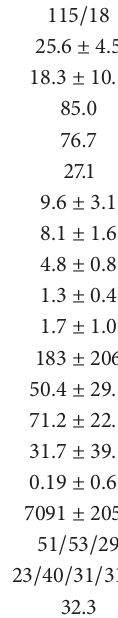
Table 2: Correlation of plasma LL-37 level with clinical